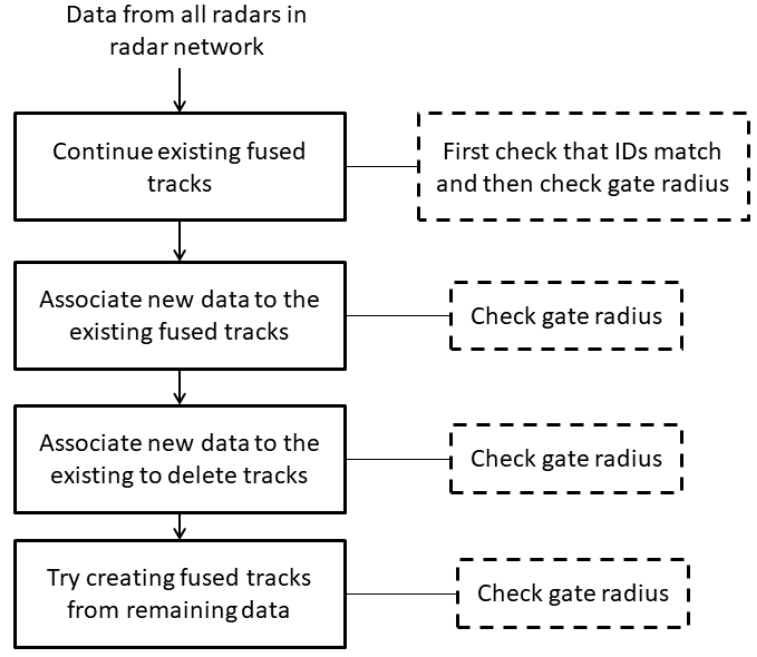
Figure 2. Main steps of the data fusion algorithm (taken from [18]).